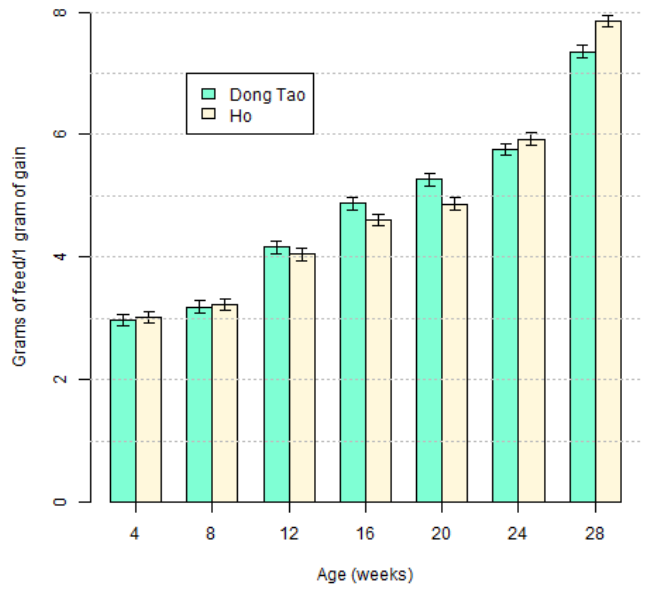
Figure 5. The feed conversion ratio (FCR) of Ho and Dong Tao chickens.